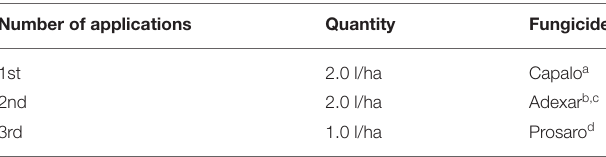
TABLE 1 | Details on fungicide applications for all treatments with fungicides for 2015–2017, source: authors based on Zetzsche et al. (2020). Number of